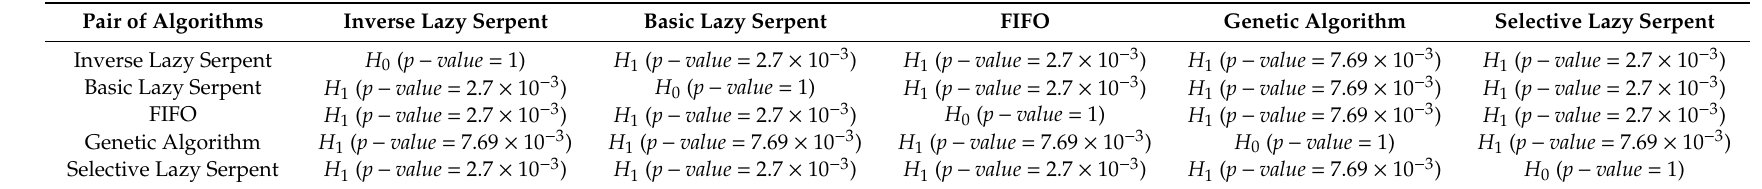
Table 3. Statistical comparison between the optimization algorithms based on the Wilcoxon test.